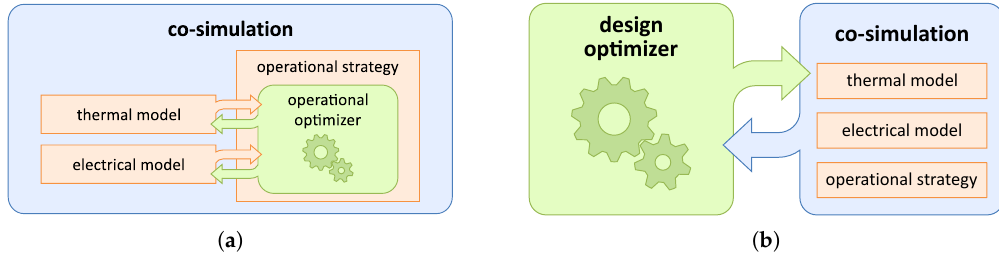
Figure 4. Schematic view of the relation between co-simulation and optimizer for: ( a ) the Optimal Control Scan (OCS); and ( b ) the Heuristic Parameter Scan